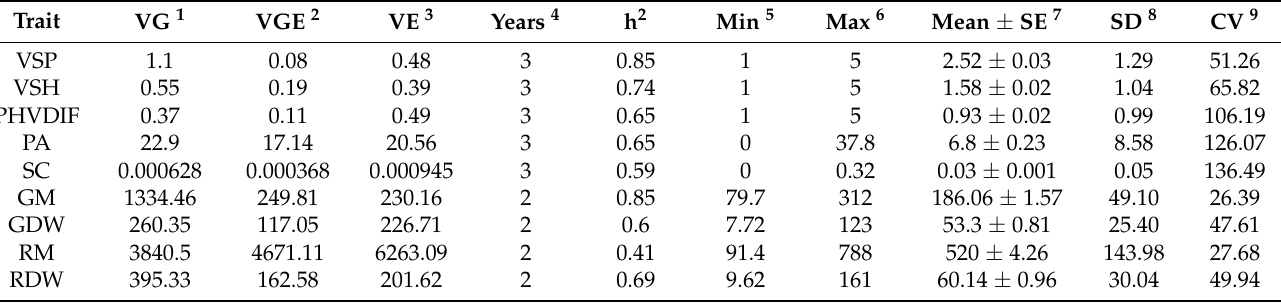
Table 1. Trait performance across years.